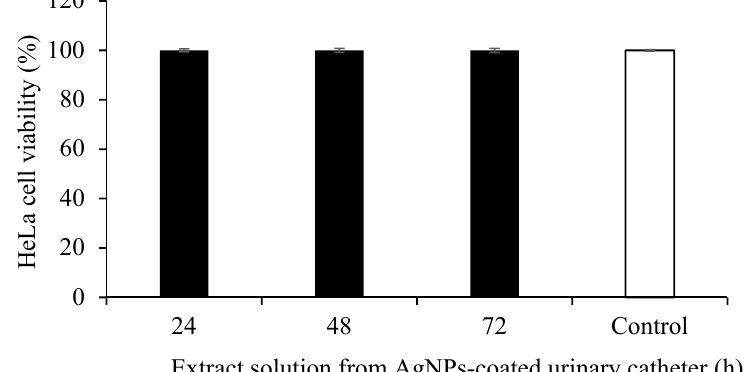
Figure 8. Cytotoxicity of AgNPs-coated urinary catheter on human cervical cancer (HeLa) cells. Cells were treated with extracted medium from AgNPs-coated urinary catheter after 24, 48, and 72 h. The values indicate mean ± SD from three independent experiments performed in triplicate, p < 0.05.